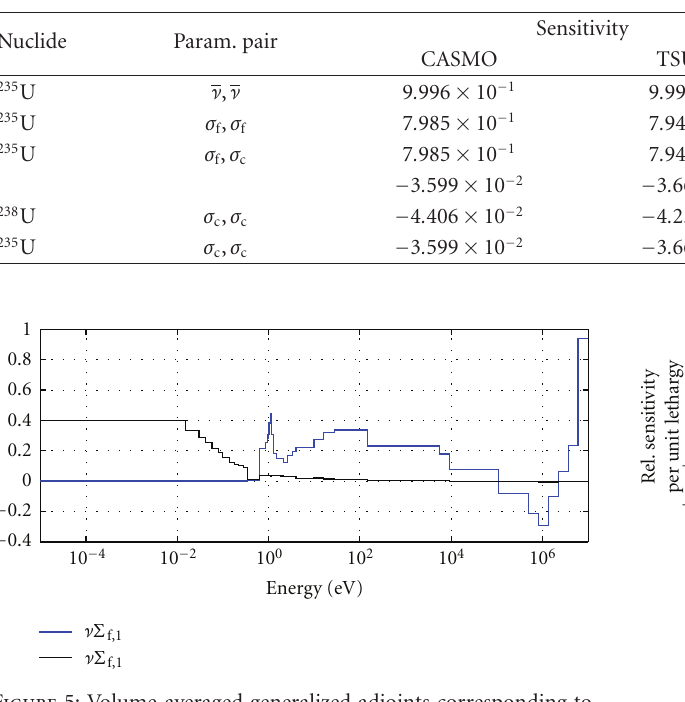
Figure 6: Sensitivity profiles of the response ν Σ f,1